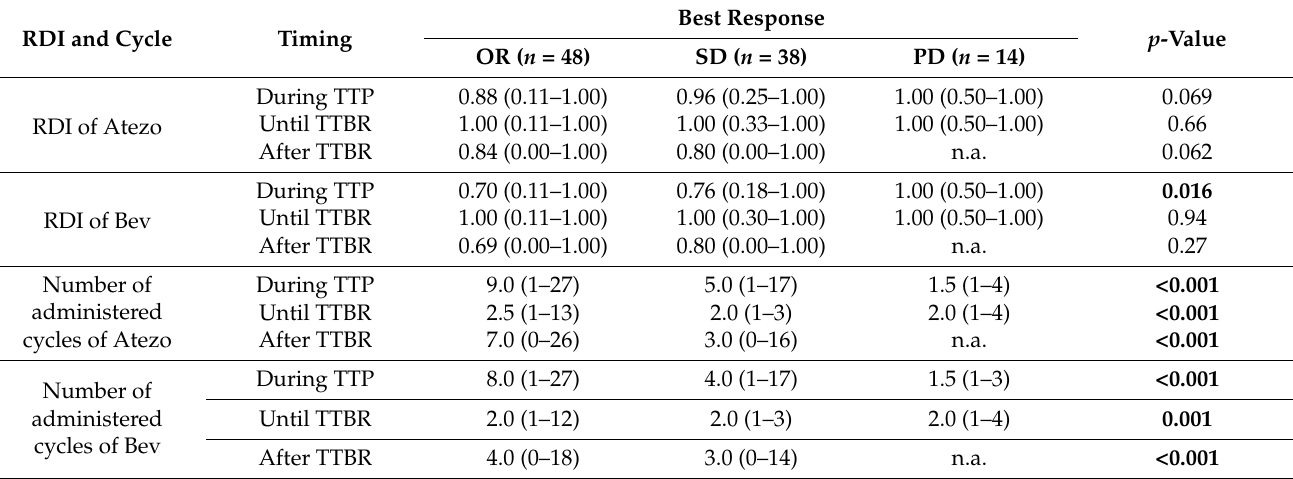
Table 6. Relationships between best response and RDI during TTP, until TTBR, and after TTBR ( n =